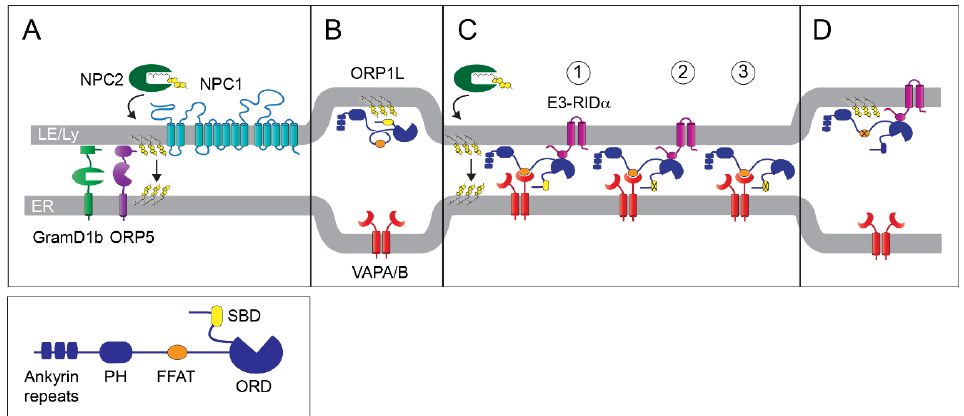
Figure 3. MCSs regulating cholesterol trafficking to the ER. ( A ) NPC1 appears to improve the kinetics of NPC2-mediated cholesterol insertion into late endosome/lysosome (LE/Lys)-limiting membranes, and to also participate in MCS formation through its interactions with ER membrane-anchored LTPs (GramD1b and oxysterol-binding protein (OSBP)-related protein 5 (ORP5)) that have both been shown to be essential for cholesterol transport. ( B ) ORP1L adopts a conformation that occludes its VAPA binding site in response to increasing levels of endosomal cholesterol. ( C ) Mechanisms that bypass NPC1 deficiency: (1) RIDα protein localized to endosomal membranes induces formation of ORP1L–VAPA MCSs that appear to mediate spontaneous cholesterol transfer to the ER following its insertion into limiting membranes by NPC2 under cholesterol-loading conditions. (2) The sterol-binding domain (SBD) in the ORP1L–ORD lid is dispensable in the RIDα pathway. (3) SBD-deleted ORP1L also reconstitutes ACAT-driven lipid droplet formation in NPC1-deficent cells independently of RIDα. ( D ) Mutations ablating the ORP1L FFAT (two phenylalanines (FF) in an acidic tract) binding motif inhibit ACAT-driven lipid droplet formation in NPC1-deficent cells with ectopic RID α expression. Inset: ORP1L domain structure. PH, Pleckstrin homology; FFAT, two phenylalanines (FF) in an acidic tract; SBD, sterol-binding domain located in lid at entrance to oxysterol-binding protein (OSBP)-related domain